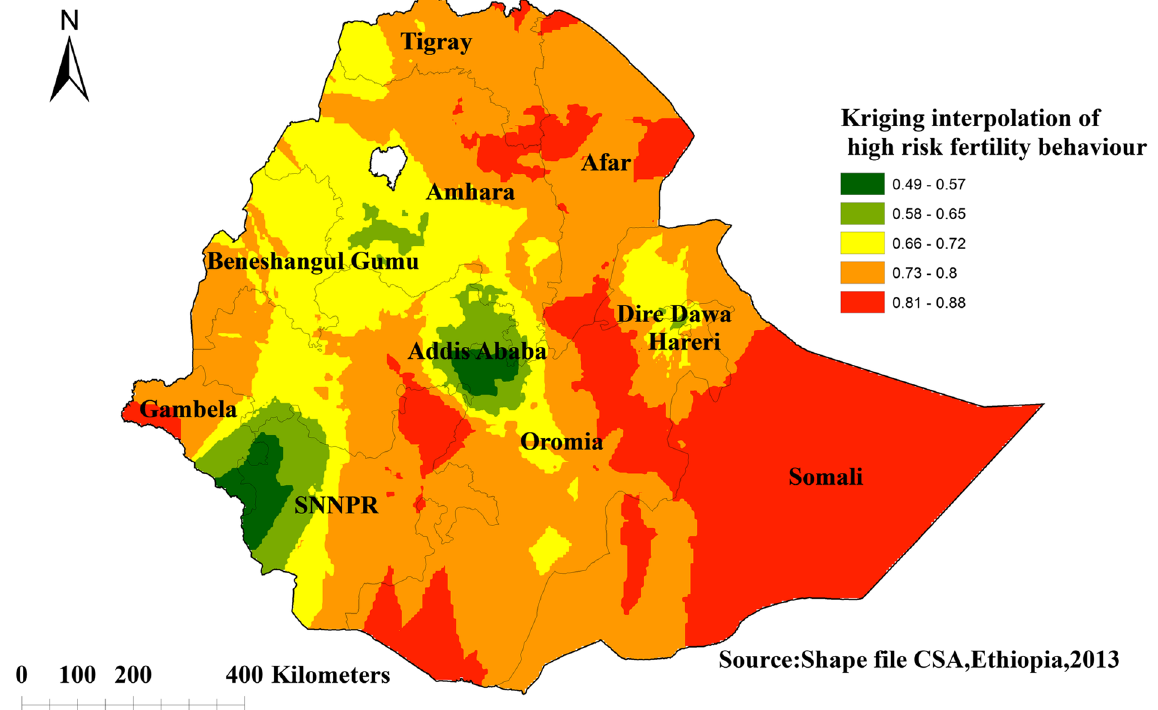
Fig. 4 Kriging interpolation of high-risk fertility behavior among reproductive-age women in Ethiopia, 2019 Ethiopian Demographic and Health